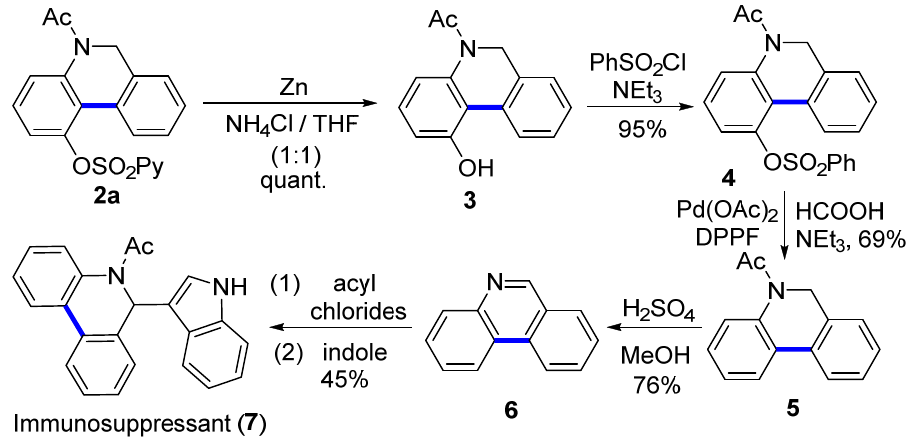
Scheme 3. The synthesis of immunosuppressant 7